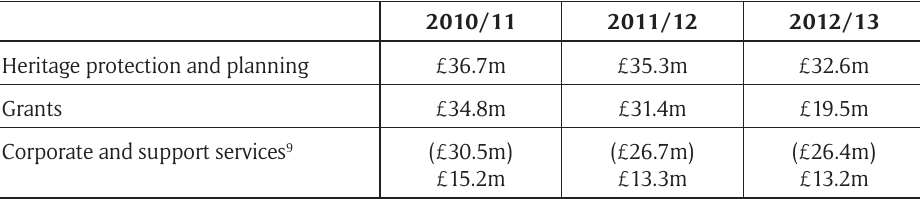
Table 4: Estimated English Heritage spending on heritage protection services,